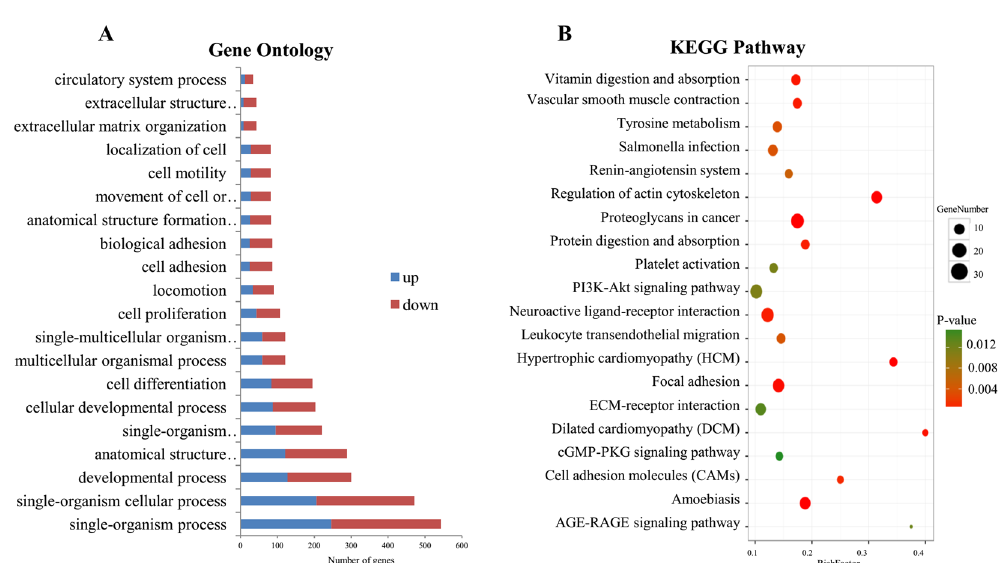
Figure 3. The Hierarchical Cluster Analysis of differentially expressed protein-coding transcripts ( A ), miRNAs ( B ), and lncRNA transcripts ( C ).